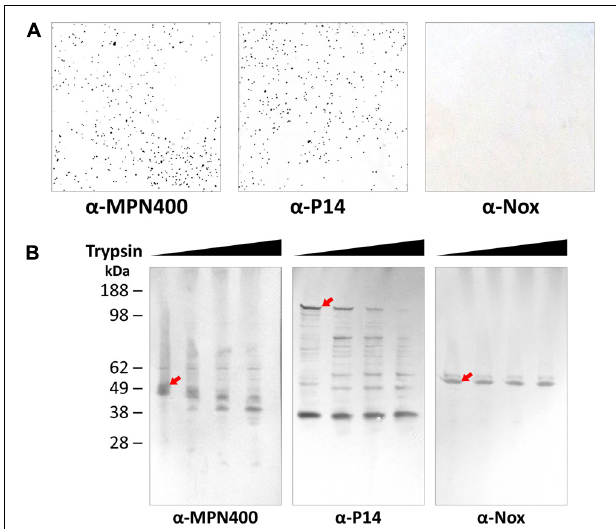
FIGURE 2 | Localization of IbpM (MPN400) on the surface of M. pneumoniae cells. (A) Results of colony blot of freshly grown M. pneumoniae colonies. Blotted colonies were treated with guinea pig α -MPN400, α -P14 (positive control), and α -NADH oxidase (Nox, negative control), respectively. (B) Reactivity of SDS-PAGE-separated and blotted whole M. pneumoniae proteins after mild treatment with increasing concentrations of trypsin. Lane 1: 0 µ g ml - 1 , lane 2: 10 µ g ml - 1 , lane 3: 40 µ g ml - 1 and lane 4: 100 µ g ml - 1 trypsin. Western blots were incubated with guinea pig α -MPN400, α -Nox and α -P14, respectively. The bands corresponding to the non-degraded proteins of interest are highlighted by red arrows. Guinea pig antibodies were detected using rabbit α -guinea pig HRP conjugated antibody.